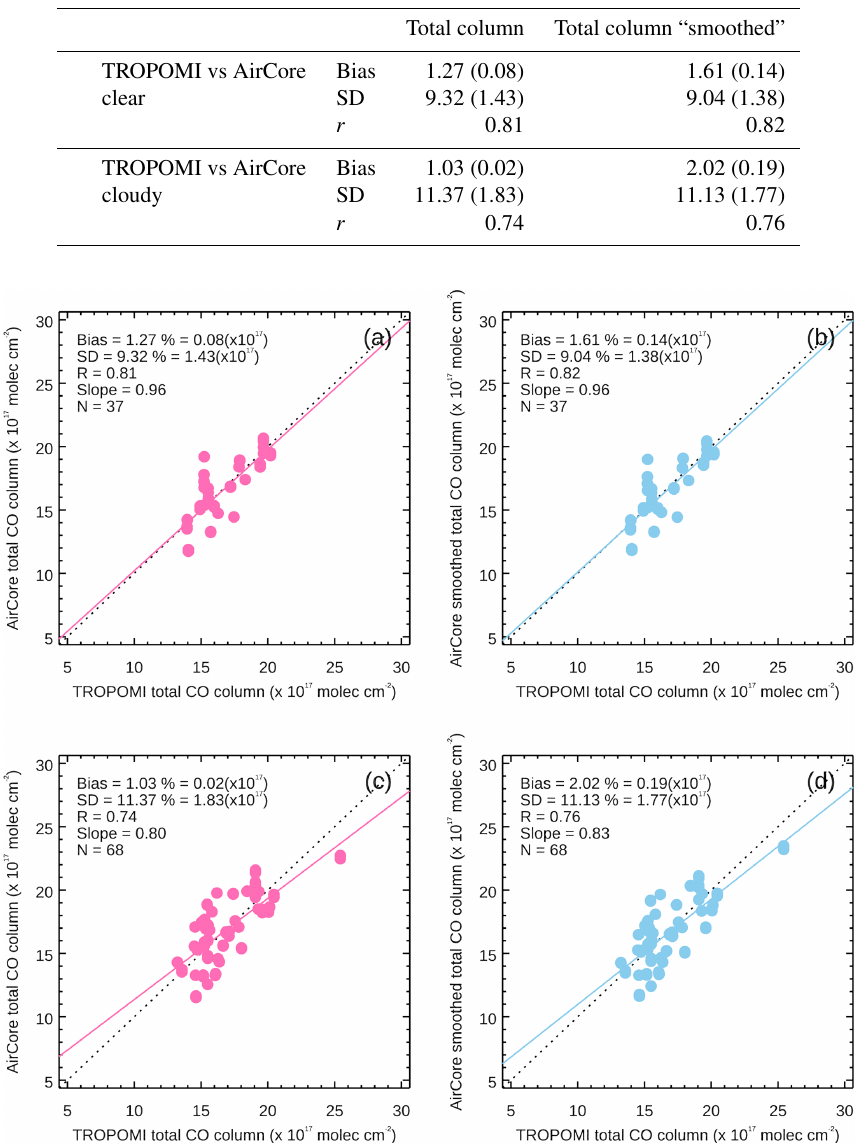
Figure 5. Comparison of total CO column values from TROPOMI and AirCore for the November 2017–July 2021 period. Top row panels (a) and (b) are both for TROPOMI clear-sky and clear-sky-like observations (i.e., QA = 1.0). Bottom row panels (c) and (d) are for TROPOMI observations with mid-level clouds (i.e., QA = 0.7). Left column panels (a) and (c) show unsmoothed AirCore data. Right column panels (b) and (d) show smoothed AirCore data to account for TROPOMI vertical sensitivity to CO. Bias values are provided in percent (%) and in units of molec.cm − 2